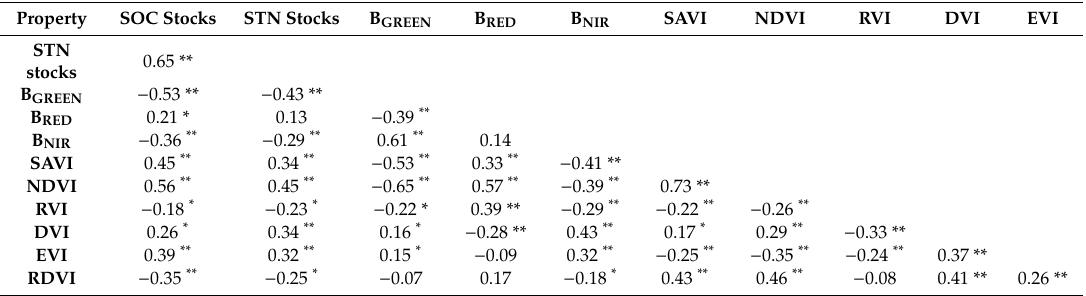
Table 3. Pearson correlation coe ffi cient between observed topsoil (0–30 cm) SOC and STN stocks (kg m − 2 ) and all remote sensing environmental variables at sample sites.